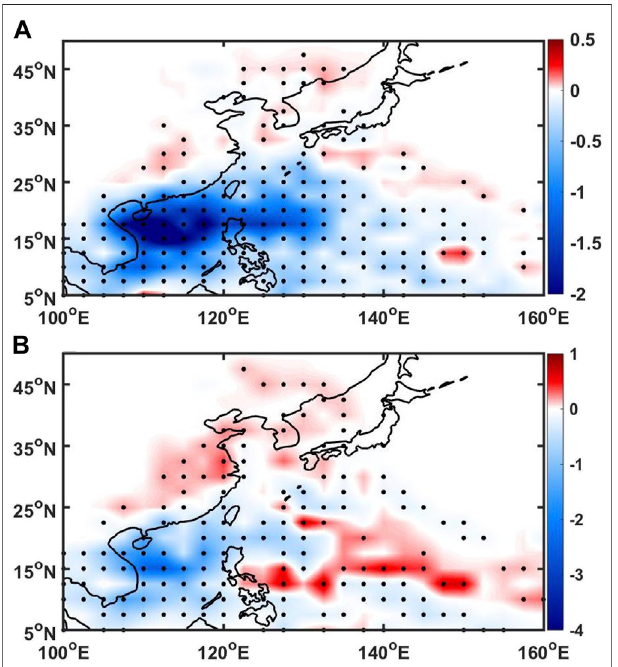
FIGURE 9 | MRI-AGCM3.2s projected WNP TC frequency change between the present-day (1979 – 2003) and global warming condition (2075 – 2099) according to RCP8.5 scenario. (A) TC frequency change in the global warming ensemble mean, computed for 2.5 ° × 2.5 ° grid boxes. (B) same as (A) but the 2075 – 2099 period is based on the CP warming cluster. Black dots represent values passing the 0.05 signi fi cance level based on Monte Carlo tests.